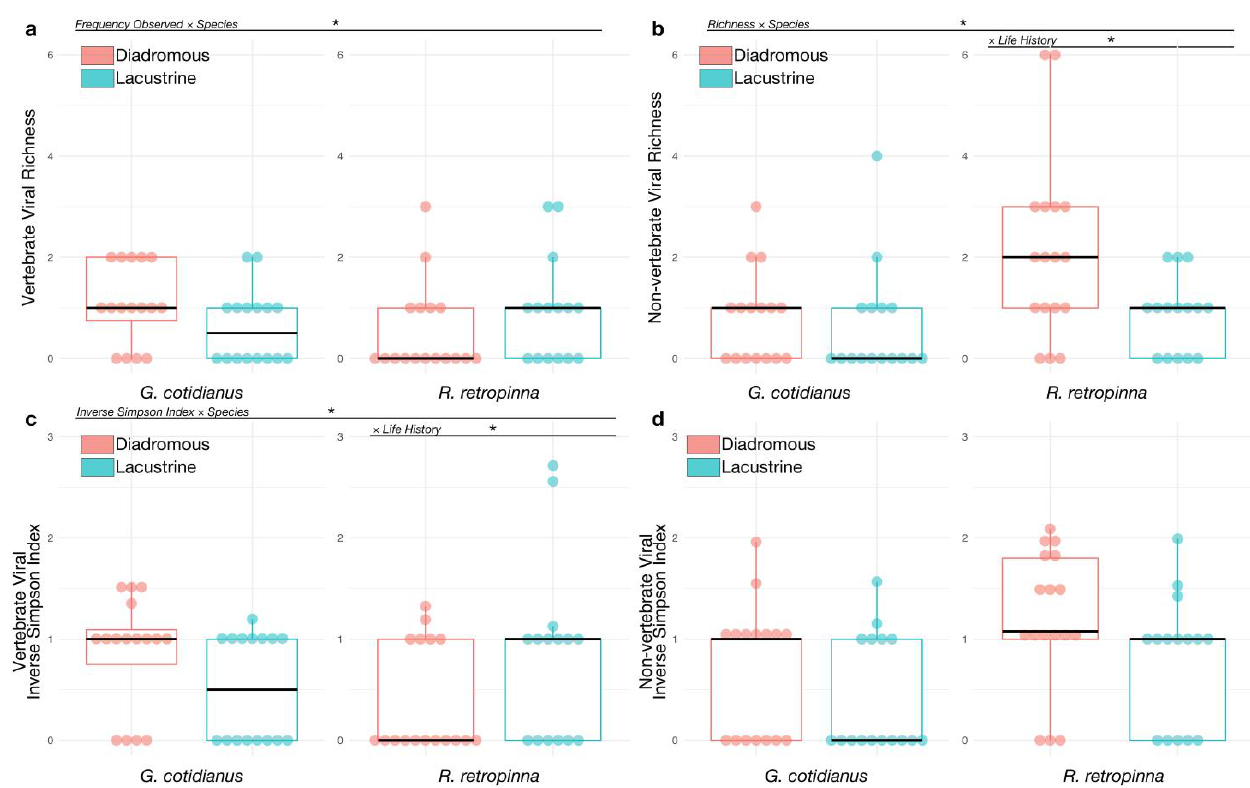
Figure 5. ( a ) Vertebrate host-associated viral richness observed in R. retropinna and G. cotidianus gill-tissue meta-transcriptomes. ( b ) Non-vertebrate host-associated viral richness observed in R. retropinna and G. cotidianus gill-tissue meta-transcriptomes. Viral richness was modelled using fish species and life history with hurdled generalised linear models which modelled the frequency of viral presence and subsequently sample richness for those samples with viruses present. ( c ) Inverse Simpson index of vertebrate host-associated virus diversity in R. retropinna and G. cotidianus gill-tissue meta-transcriptomes. ( d ) Inverse Simpson index of non-vertebrate host-associated virus diversity in R. retropinna and G. cotidianus gill-tissue meta-transcriptomes. Inverse Simpson index was modelled using species and life history with Tweedie family generalised linear models for zero-inflated continuous data. Asterisks indicate significant effects at p < 0.05.